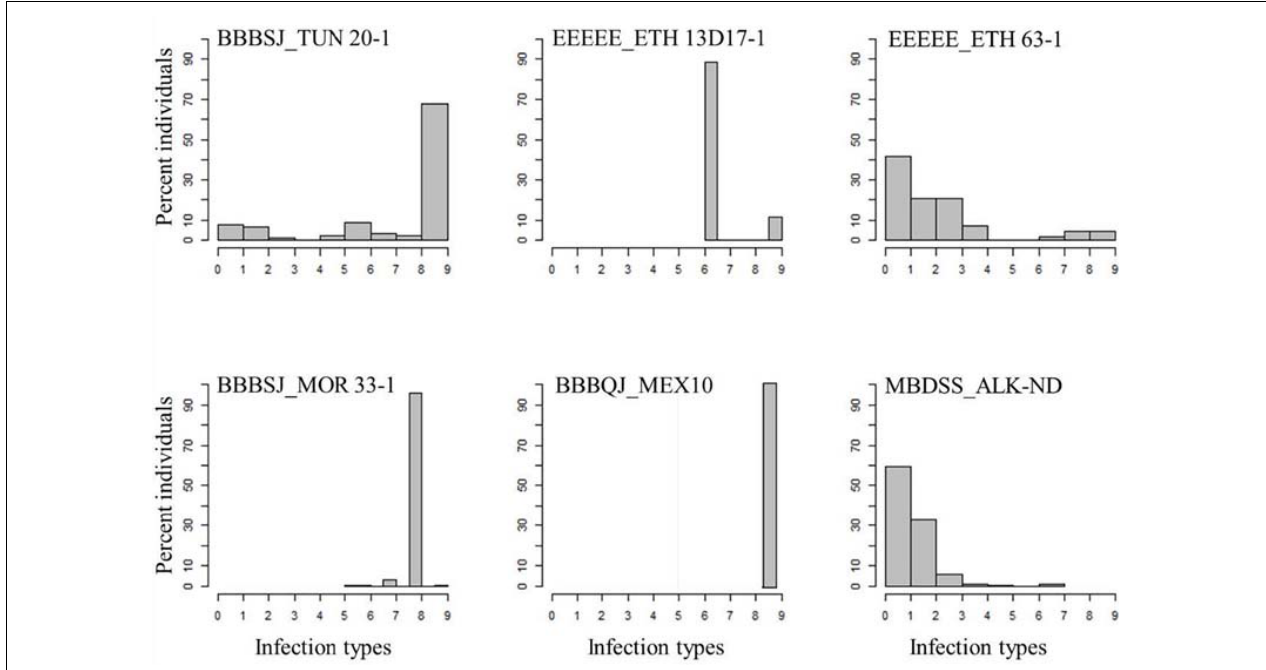
FIGURE 1 | Distributions of the seedling responses of the durum wheat genotypes to Puccinia triticina isolates BBBSJ_TUN 20-1, EEEEE_ETH 13D17-1, EEEEE_ETH 63-1, BBBSJ_MOR 33-1, BBBQJ_MEX10, and MBDSS_ALK-ND. X-axis corresponds to linearized Stakman scale